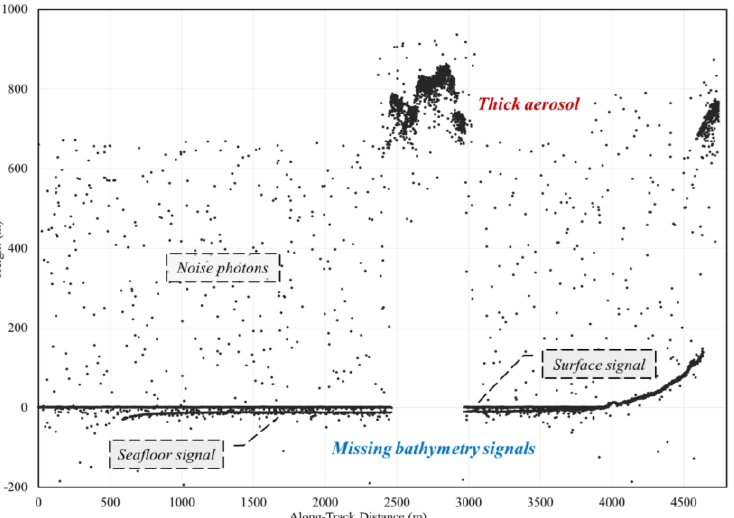
Figure 1. ICESat-2/ATL03 along-track point cloud profile in a sea area containing thick aerosols. The laser points gather into two obvious strip-like clusters on the surface and seafloor. At the same time, due to the absorption and scattering of the laser by the thick aerosols, there is a missing bathymetric signal area in the signal strip.